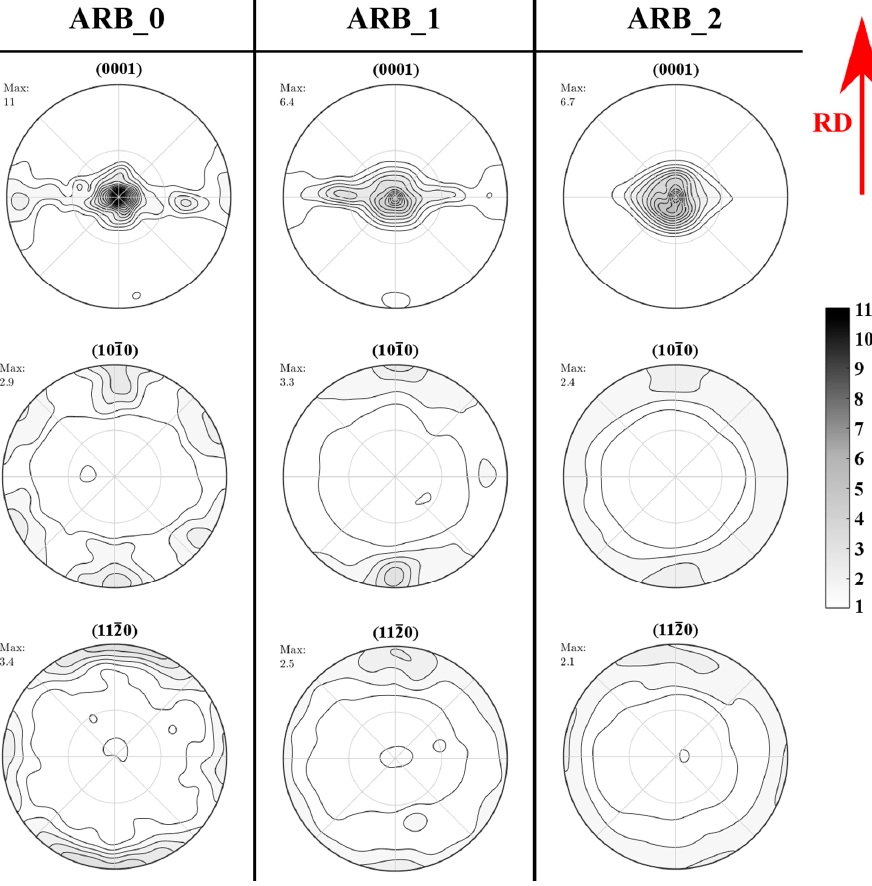
Figure 6. XRD pole figures of the investigated samples.